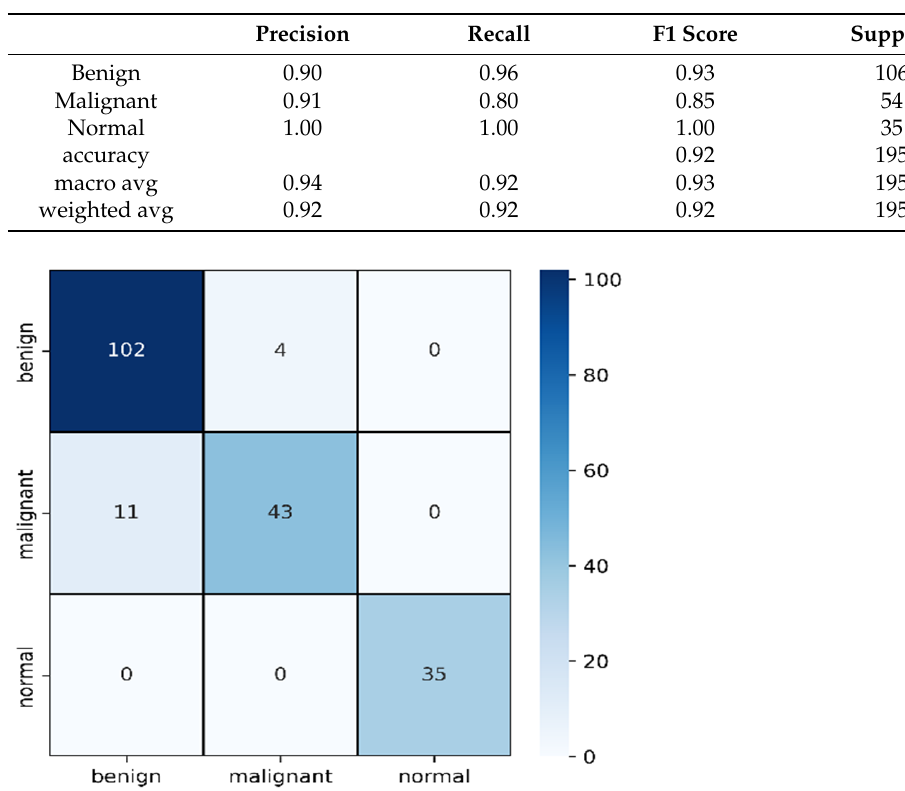
Table 5. Precision, Recall, and F1 score for the combined image on 25% of test data.